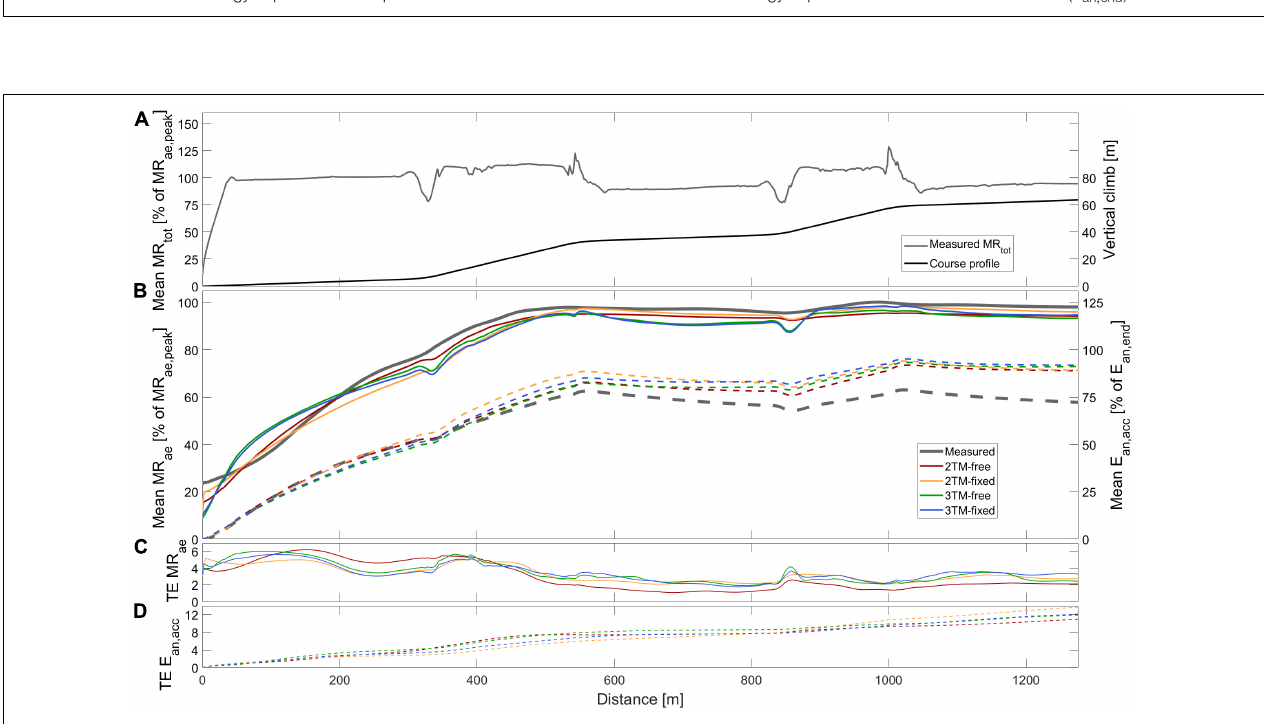
FIGURE 2 | Measured and modeled metabolic variables during STT2 including (A) group mean of total metabolic rate (MR tot ), course profile, (B) mean aerobic metabolic rate (MR ae , solid), accumulated anaerobic energy expenditure (E an , acc , dashed), (C) typical error of aerobic metabolic rate (TE MR ae ), and (D) typical error of anaerobic accumulated energy expenditure (TE E an , acc ). Metabolic rates are expressed relative to peak aerobic metabolic rate in STT1 (MR ae , peak ) and accumulated anaerobic energy expenditure is expressed relative to the accumulated anaerobic energy expenditure at the end of the course (E an , end ).